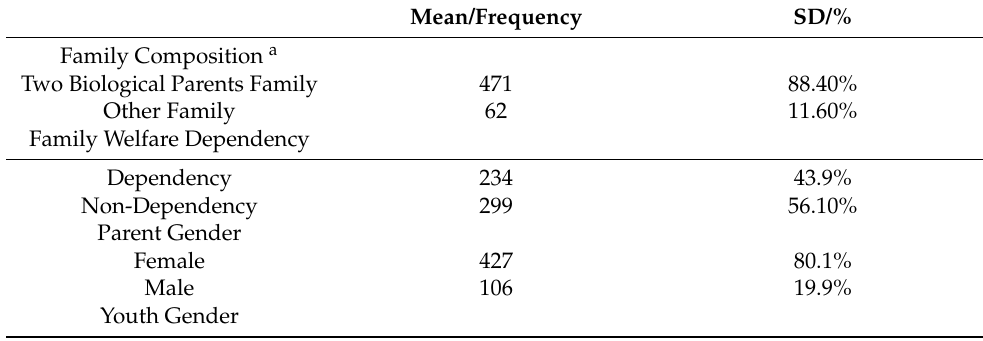
Table 1. Descriptive Statistics of Sociodemographic Characteristics of the Parent-Youth